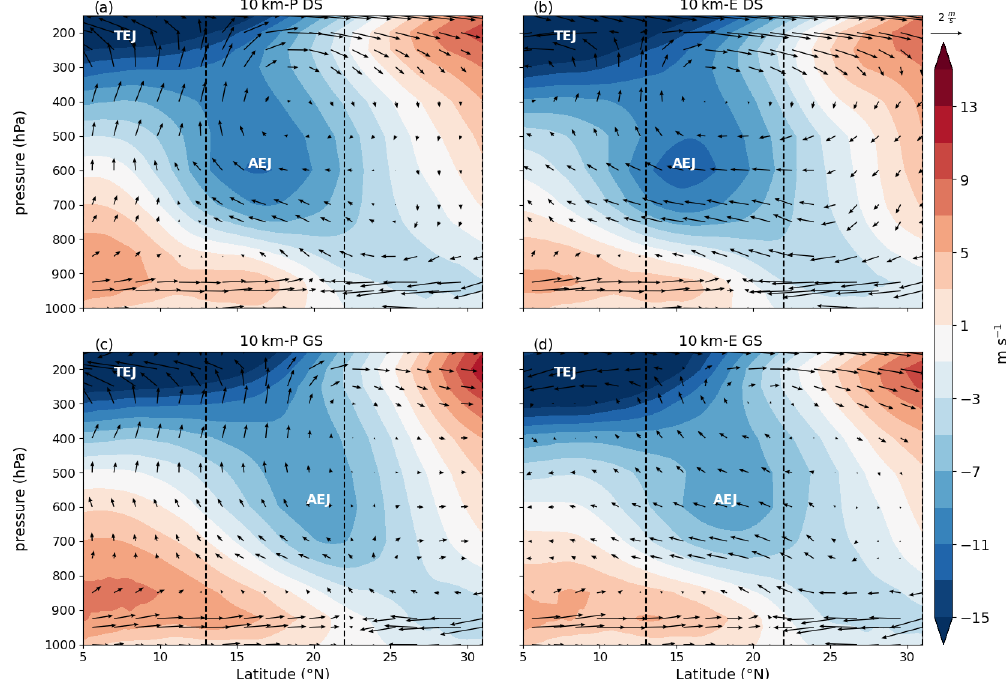
Figure B2. Vertical cross section of the wind field over the WA domain (Fig. 1). The shading displays the mean zonal wind, and the arrows display the mean meridional and vertical wind for the 10km-P DS (a) and GS (c) as well as the 10km-E DS (b) and GS (d) simulation, respectively. Note that the vertical wind speed is multiplied by 100 to make arrows more visible. The locations of the African easterly jet (AEJ) and the tropical easterly jet (TEJ) are indicated by the labels. The dashed vertical lines indicate the borders of the coastal, Sahel, and Sahara domain also displayed in Fig. 1. Table B1. JAS mean values of 12:00UTC CAPE along with CIN and JAS mean level of free convection (LFC) as well as total cloud cover for the coastal, Sahel, and Sahara region (Fig. 1) for the 10km-E and the 10km-P DS and GS simulation,